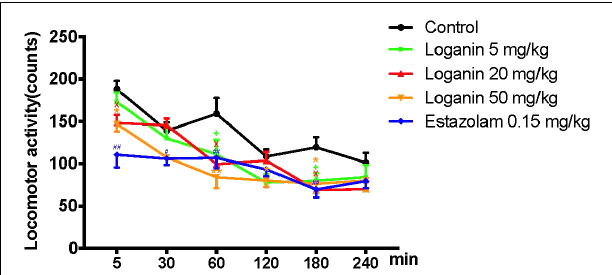
FIGURE 3 | Inhibitory effect of loganin on locomotor activity in normal mice. 5–240 min after administration of loganin (5, 20, 50 mg/kg, i.g.) or estazolam (0.15 mg/kg, i.g.), spontaneous locomotor activity was monitored. Data are presented as means ± SEM ( n = 12). + P < 0.05, loganin 5 mg/kg, vs. the control group; X P < 0.05, loganin 20 mg/kg, vs. the control group; ∗ P < 0.05, ∗∗ P < 0.01, loganin 50 mg/kg vs. the control group; # P < 0.05, ## P < 0.01, estazolam 0.15 mg/kg, vs. the control group (one-way ANOVA followed by Student-Newman-Keuls test).